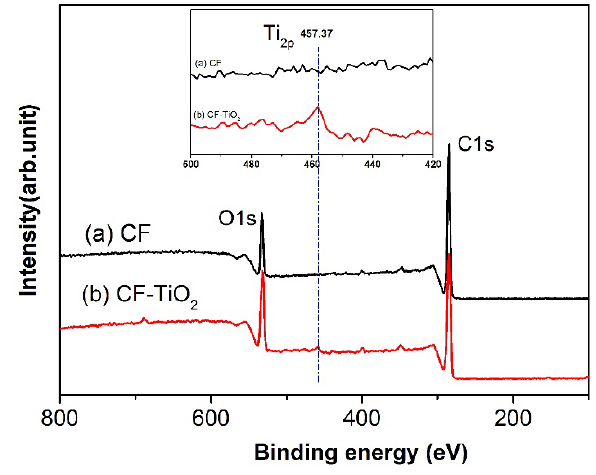
Figure 8. XPS spectrum of untreated CF ( a ) and CF-TiO 2 ( b ). Table 1. Chemical atomic compositions on the surface of fibers.